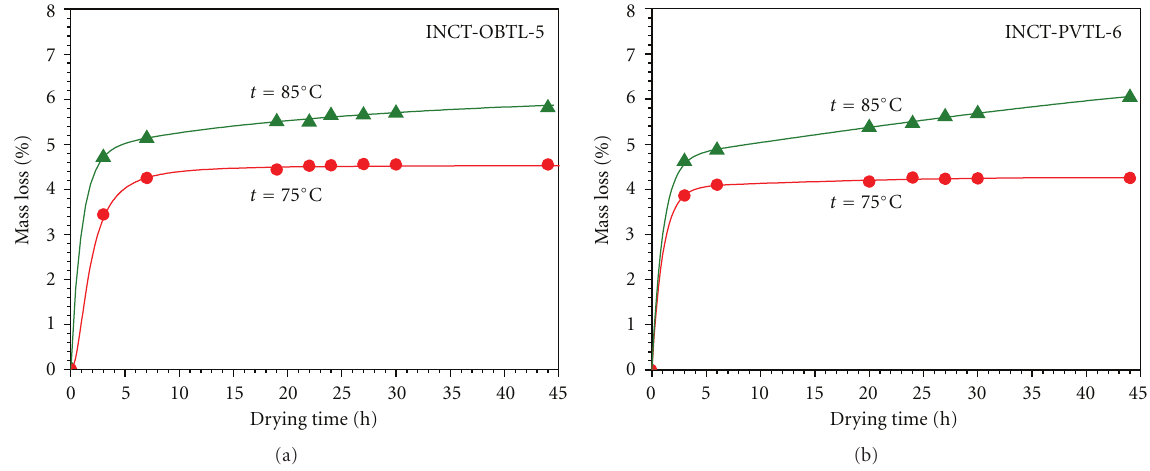
Figure 3: Water desorption curves for INCT-OBTL-5 and INCT-PVTL-6 at 75 and 85 ◦